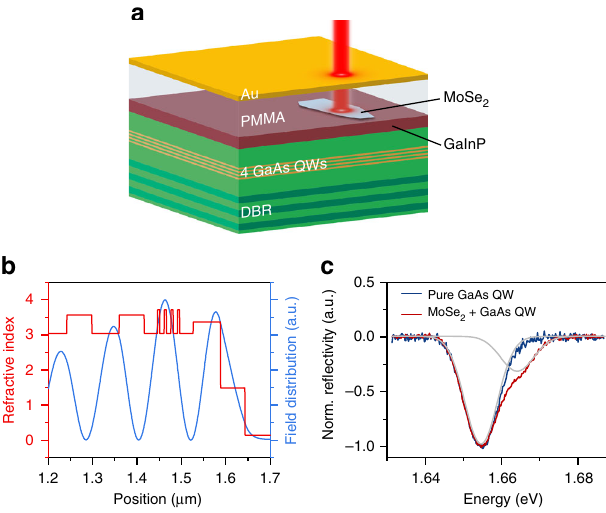
Fig. 1 Hybrid Tamm monolayer device. a Schematic illustration of the Tamm-plasmon device with the embedded MoSe 2 monolayer. The monolayer is capped with PMMA, whose thickness primarily determines the frequency of the device ’ s optical resonance. b Calculation of the electromagnetic fi eld intensity in the heterostructure. The fi eld distribution in the device is designed to yield optimal overlap with the position of the quantum wells as well as the atomic monolayer. c Re fl ectivity spectrum of the device prior to capping the structure with Au. The two absorption dips are correlated with the GaAs exciton and the MoSe 2 neutral excitonic